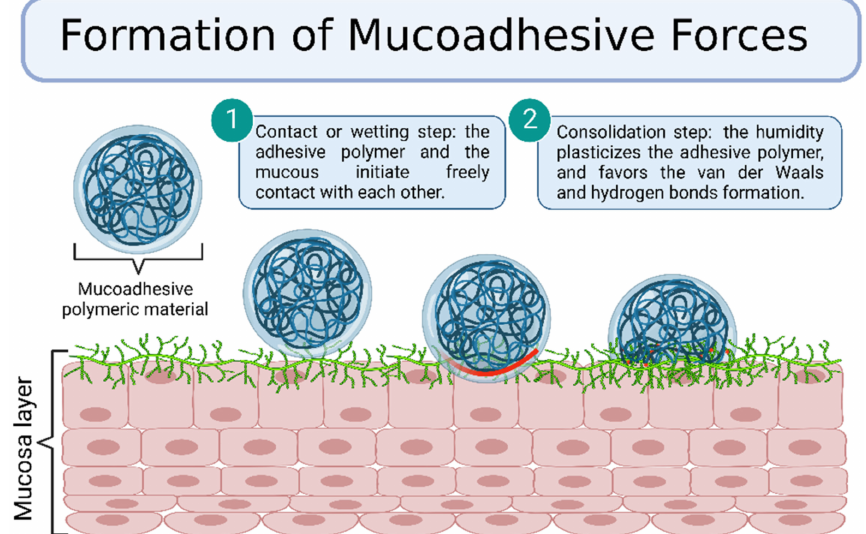
Figure 6. Formation of mucoadhesive forces scheme. Created with BioRender.com Adapted from Biomaterials and Bionanotechnology, Tekade et al., Thiolated-Chitosan: A Novel Mucoadhesive Poly- mer for Better-Targeted Drug Delivery Muktika, pages 459–493, Copyright (2019), with permission from Elsevier